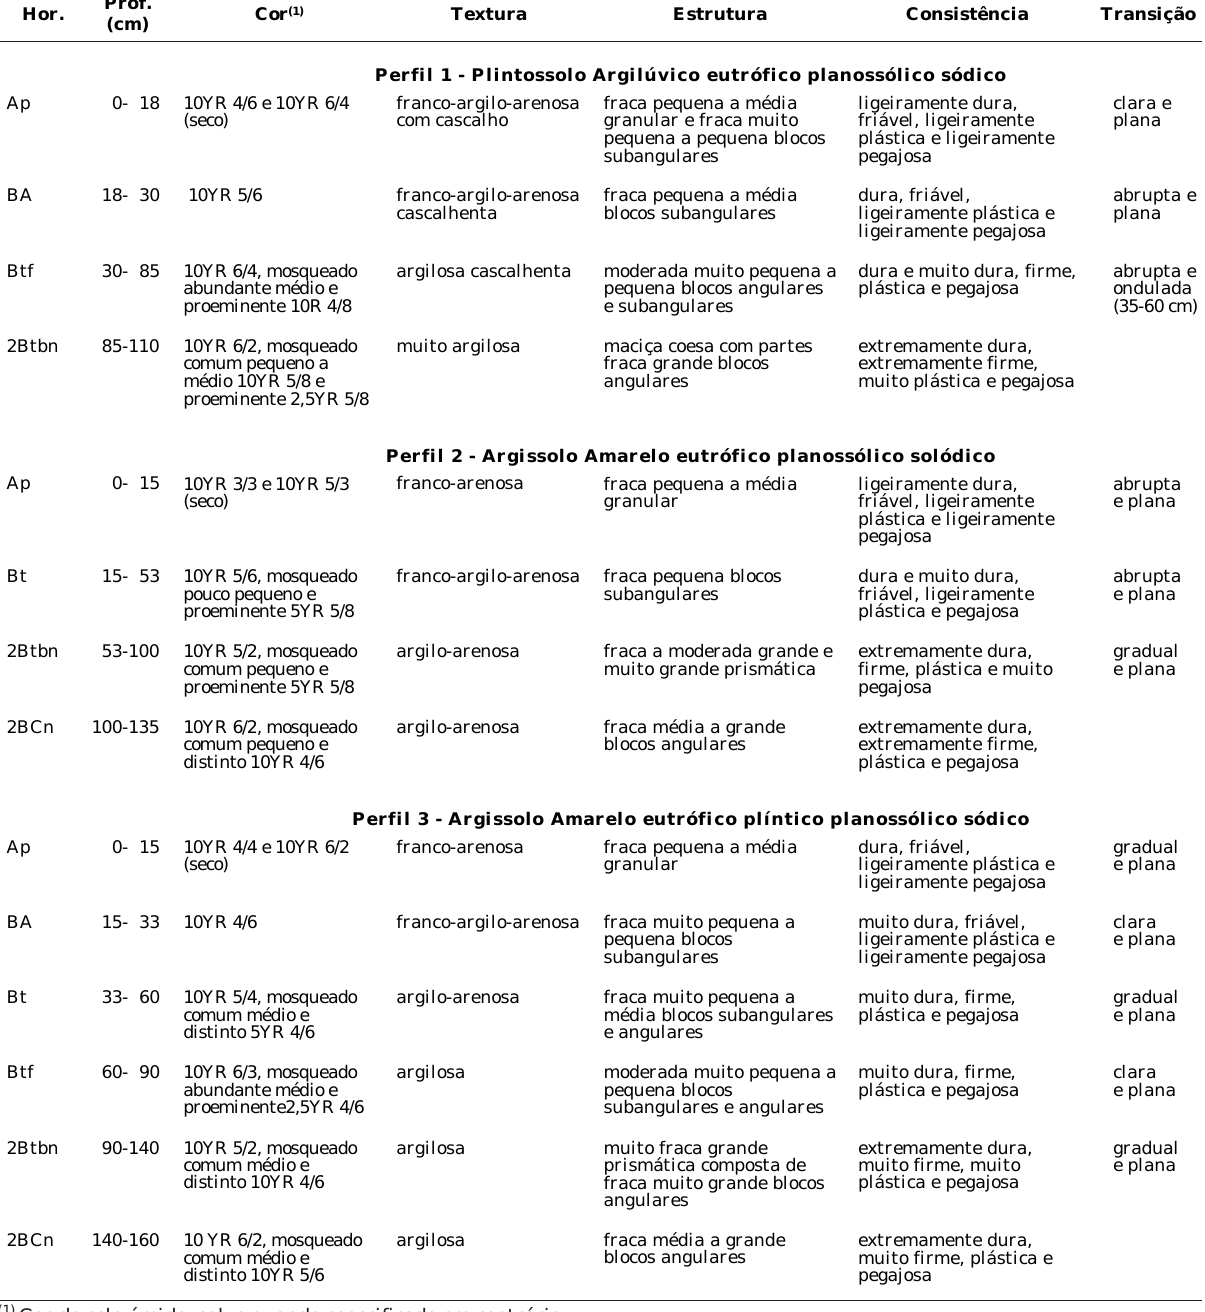
atende, entretanto, ao requisito de apresentar mudança textural abrupta, ocorrendo abaixo de um horizonte Bt. No SIBCS, o horizonte B plânico é, por definição, precedido por uma mudança textural abrupta e subjacente a um horizonte A ou E. o estabelecido na definição do horizonte B